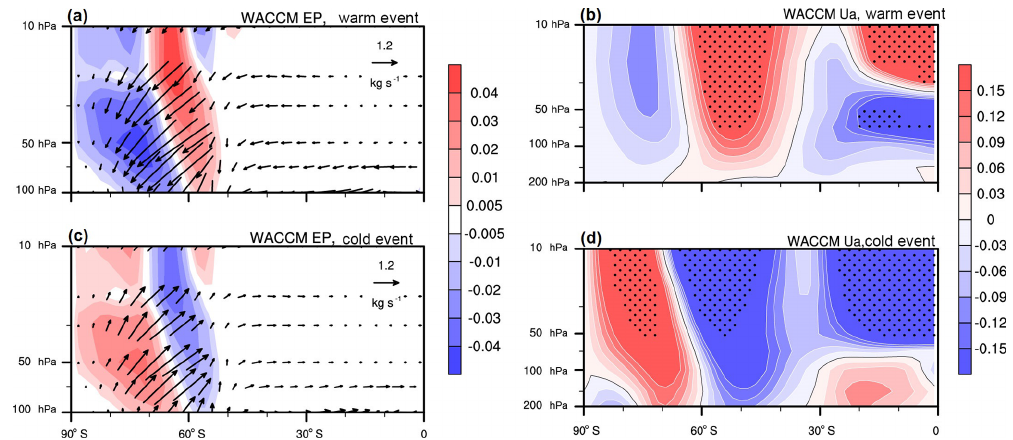
Figure 9. Differences in E–P flux vectors (black arrows) and divergence (color shading) in austral spring between (a) S2 and S1, and (c) S3 and S1. Units for the horizontal and vertical vector directions are 10 7 and 10 5 kgs − 1 , respectively. (b) and (d) as (a) and (c) but for zonal wind (ms − 1 ). Statistical significance above the 95% confidence level is stippled.